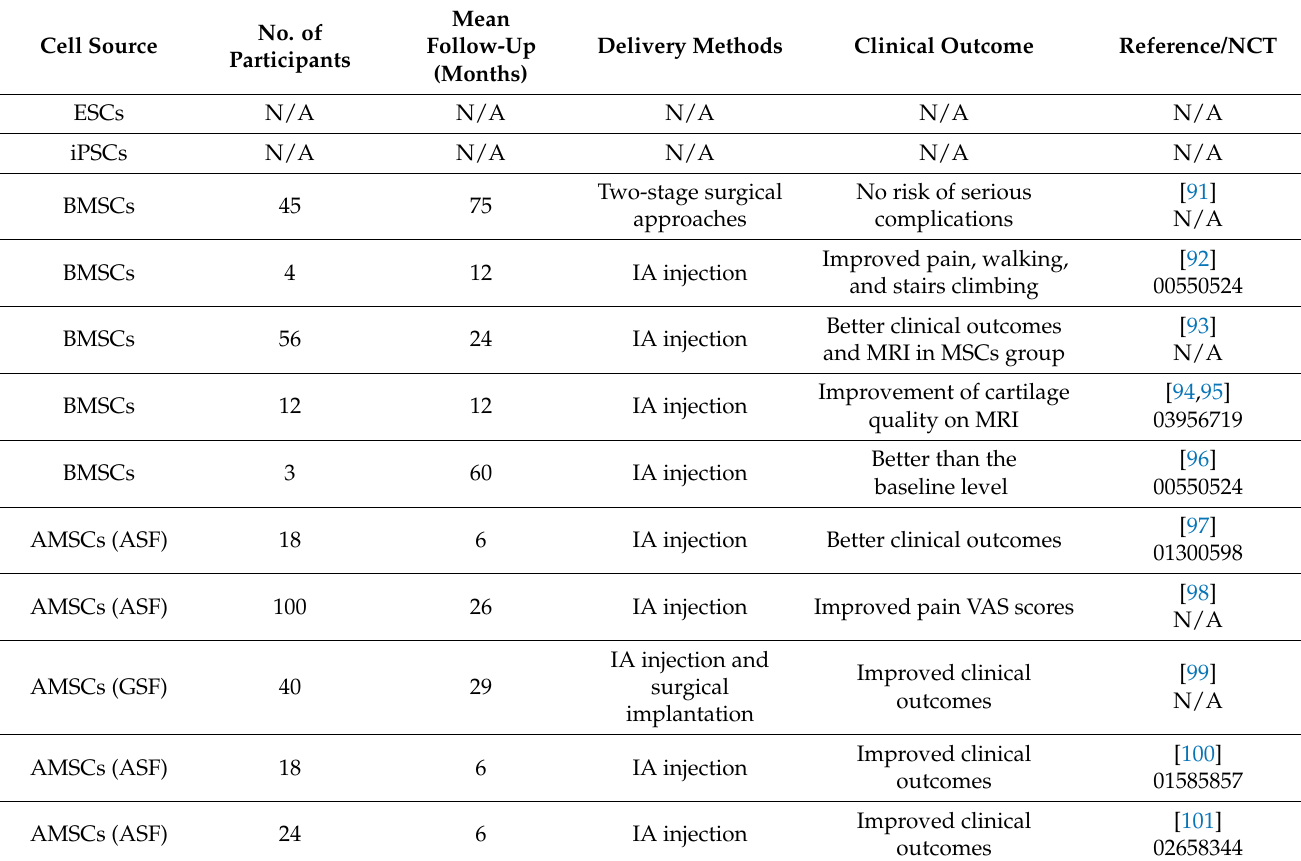
Table 4. Detailed clinical studies of ESCs, iPSCs, and MSCs in